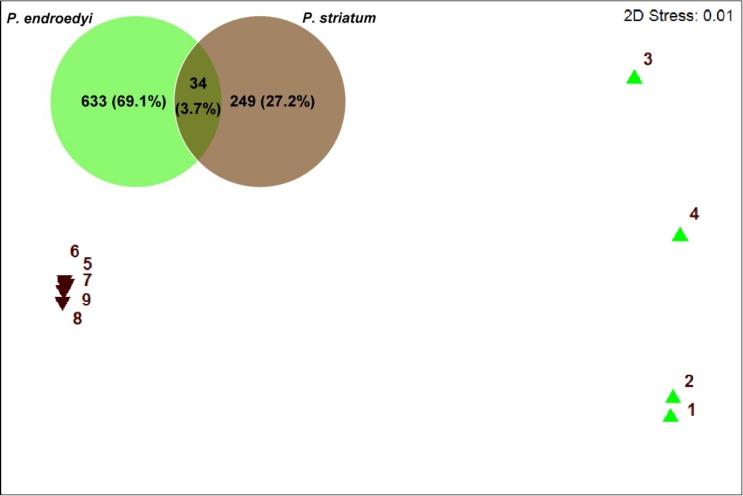
nMDS ordination plot based on Bray-Curtis distance matrices of bacterial 16S rRNA gene pyrosequencing data for P. endroedyi and P. striatum individuals.A stress value of less than 0.1 represents a high quality ordination. Pachysoma endroedyi and P. striatum are represented by green and inverted brown triangles, respectively.